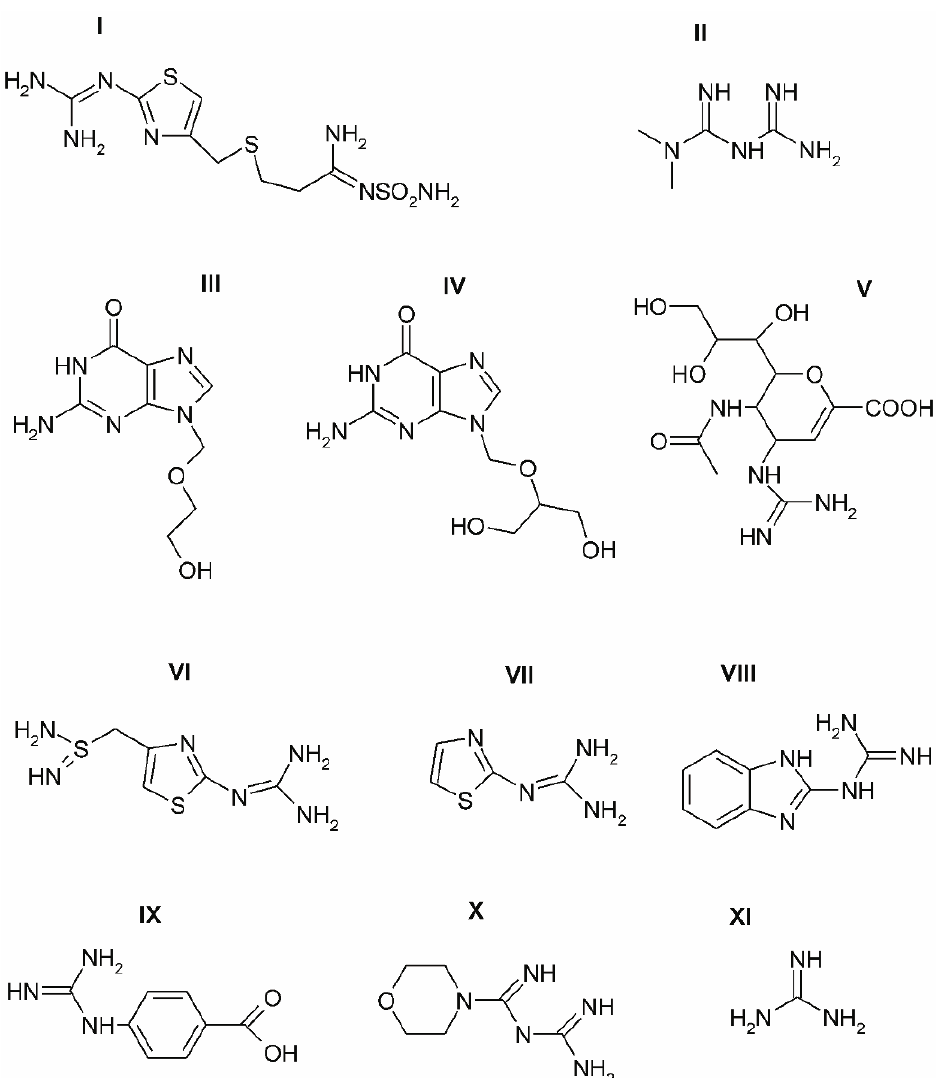
Figure 1. The chemical structures of the studied guanidine compounds: famotidine (I), metformin (II), acyclovir (III), ganciclovir (IV), zanamivir (V), GTAMITU (VI), GTA (VII), GBI (VIII), GBA (IX), moroxydine (X), guanidine